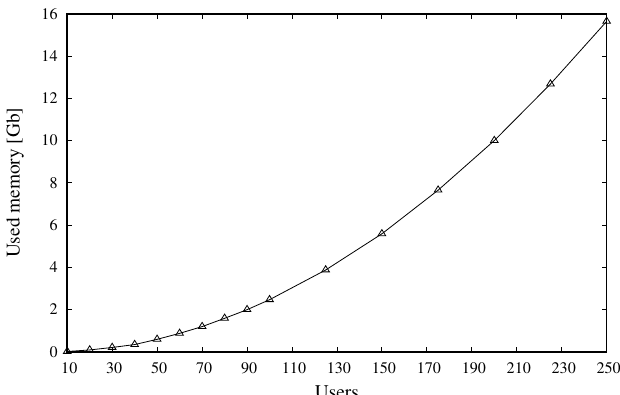
Figure 9. Amount of memory needed to solve the prosumer problem using the Unified approach, versus the number of